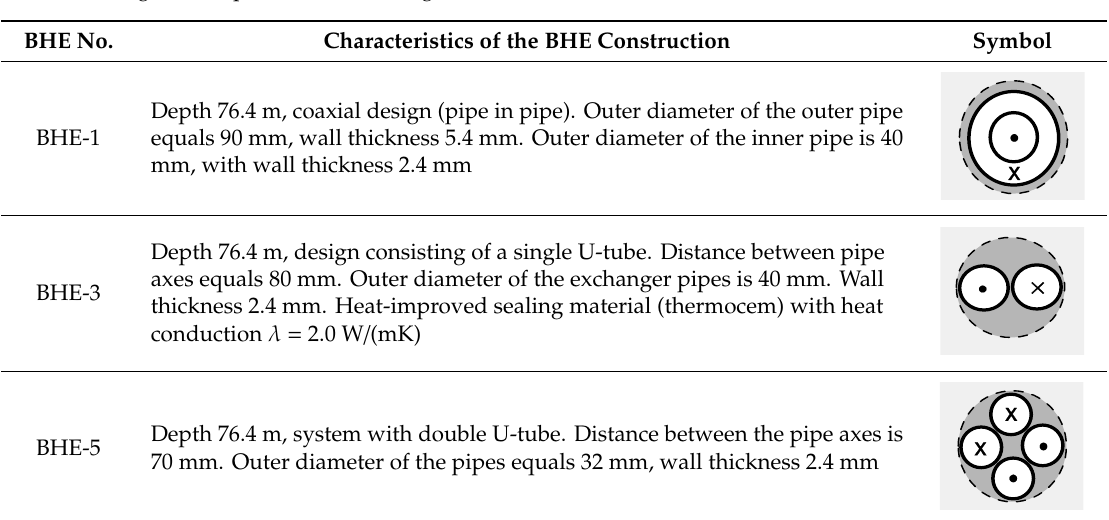
Table 1. Characteristics of the researched borehole heat exchangers belonging to the Laboratory of Geoenergetics, Department of Drilling, Oil and Gas AGH UST [40]. BHE No. Characteristics of the BHE Construction Symbol